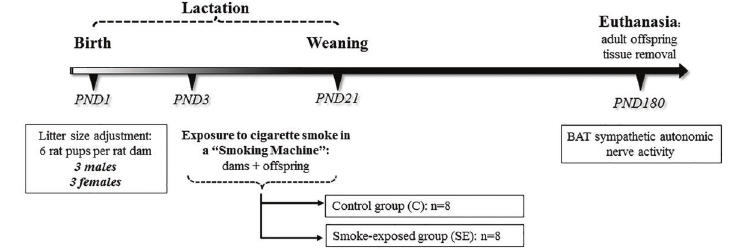
Figure 1. Experimental timeline. PND: postnatal day; BAT: brown adipose